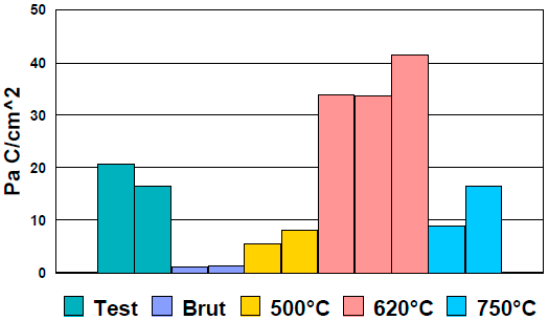
Figure 21. Normalized charge (Pa) measured by EPR.